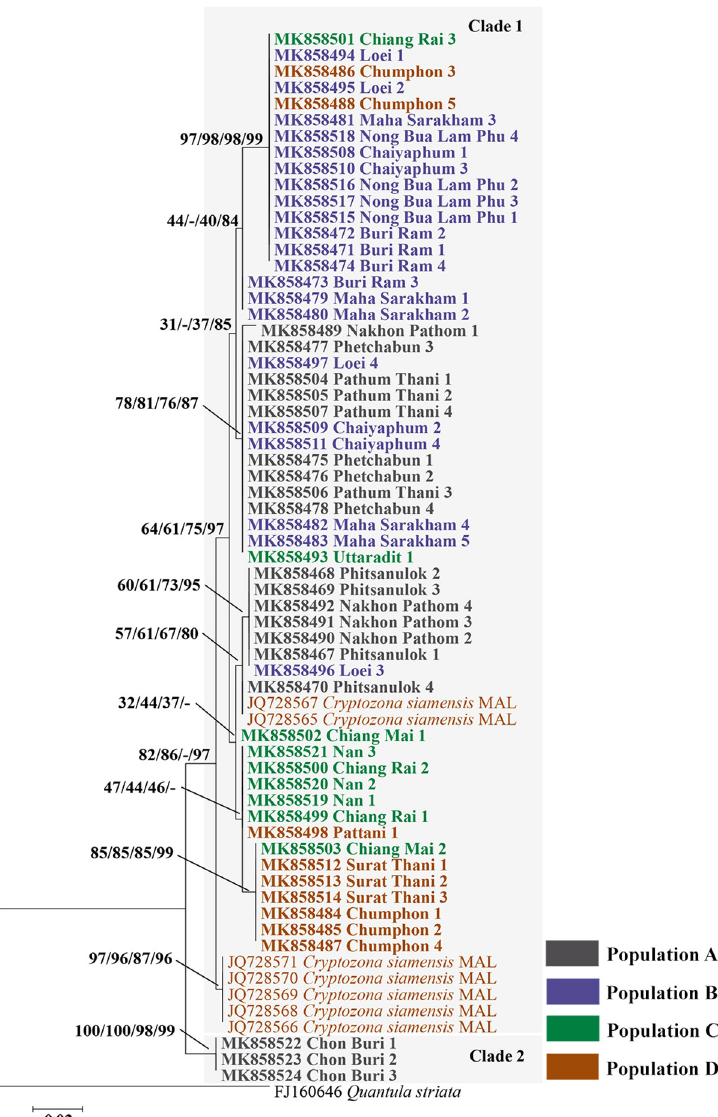
Fig 2. Maximum likelihood phylogenetic tree generated from 58 sequences of a partial 16S rRNA sequence (402 bp) of C . siamensis , collected from across Thailand. Support values (ML bootstrap/NJ bootstrap/MP bootstrap/ Bayesian posterior probabilities) are shown above the branches. Bold letters indicate the sequences obtained in the present study. Quantula striata was used as the out-group. MAL = Malaysia. each population ranged from 0.6238 in population B to 0.8833 in population D, with a mean of 0.8779. Nucleotide diversity in each population ranged from 0.0088 in population C to 0.0169 in population A, with a mean of 0.0169 (Table 2). Fourteen haplotypes (CO1-CO14), from the 58 sequences of the 4 populations (A, B, C, and D) in Thailand, were identified, based on the COI genes (602 bp) with nucleotide variations at 57 sites (S5 Table). Of these, 9 haplotypes (CO6, CO7, CO8, CO9, CO10, CO11, CO12, CO13, and CO14) were unique, and 5 haplotypes were shared by at least two populations (Table 1 and S6 Table). The geographically spread haplotype CO1 was shared between the population B, C, and D. Haplotype CO2 was shared between the populations A, B, and C. Haplotype CO3